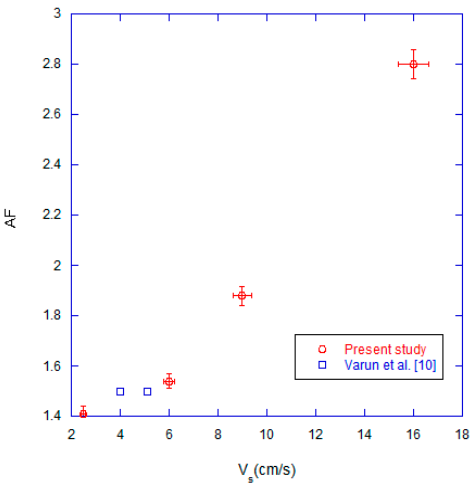
Figure 5. Effect of the superficial velocity on Air Fuel ratio(AF).